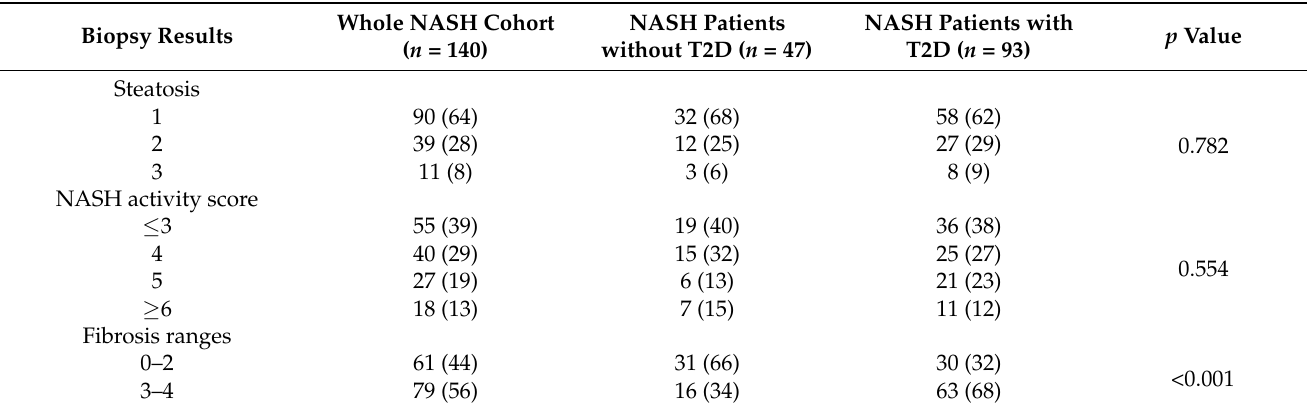
Table 2. Grade of steatosis; NASH activity score and fibrosis in the entire NASH cohort and subdi- vided respect to T2D status.